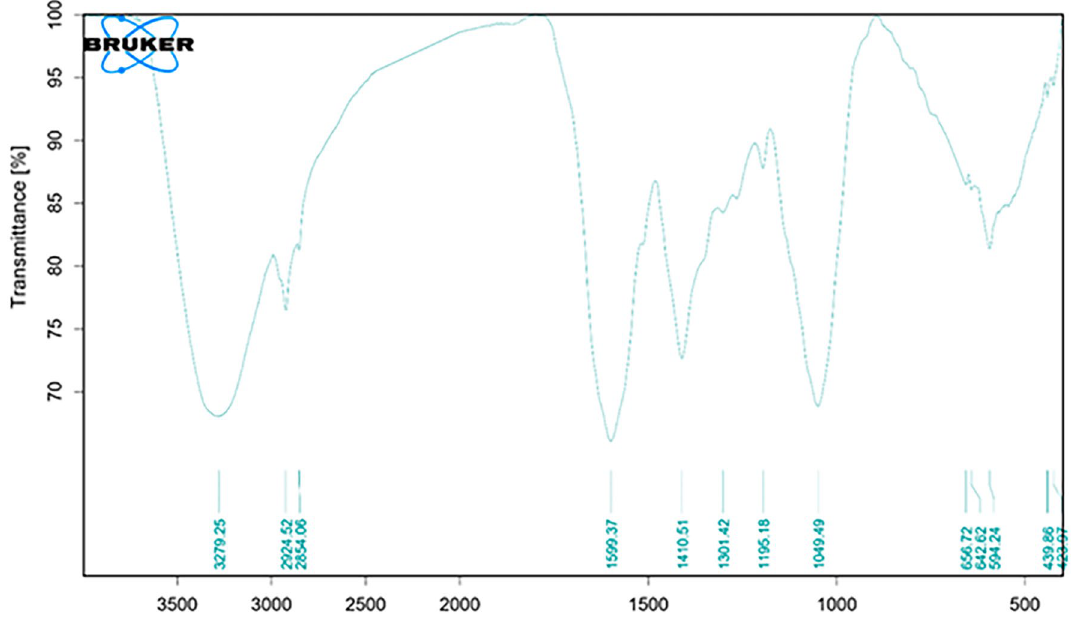
Fig. 1 FT-IR spectrum of crude methanolic extract of Enhalus acoroides (L.f.) Royle